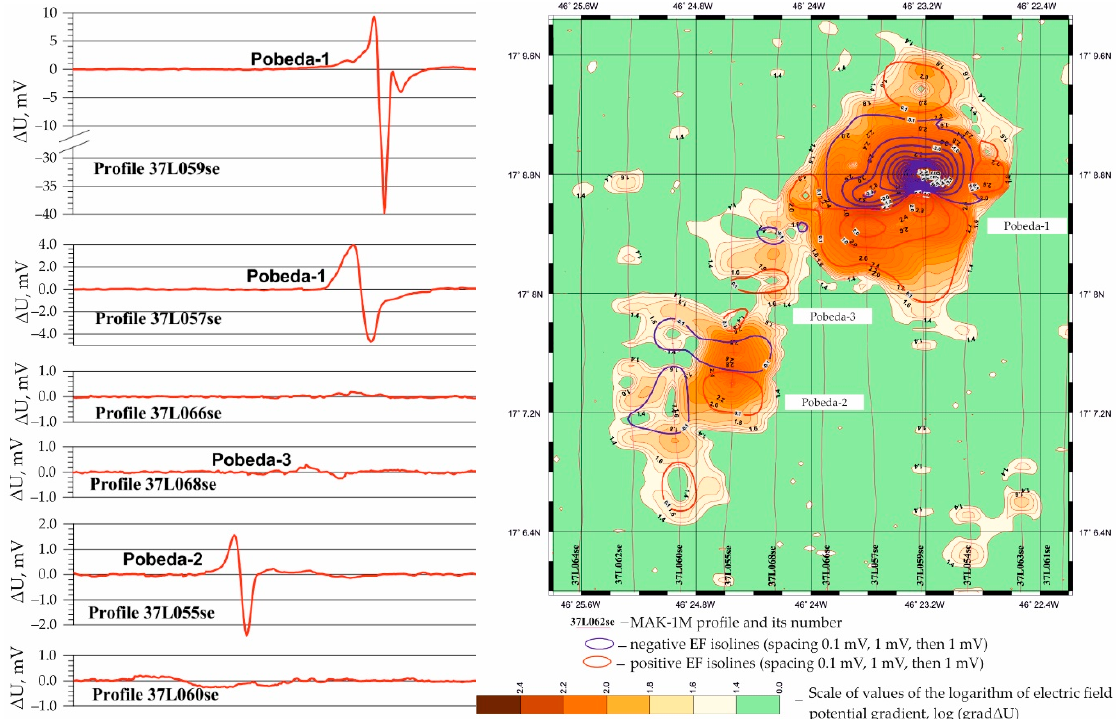
Figure 3. ( Left ) the EF anomalies near the Pobeda hydrothermal cluster; ( right ) combined scheme of isolines of the EF ( Δ U) and the logarithm of the gradient Δ U, Pobeda hydrothermal cluster (modified after Gablina et al. [34]).